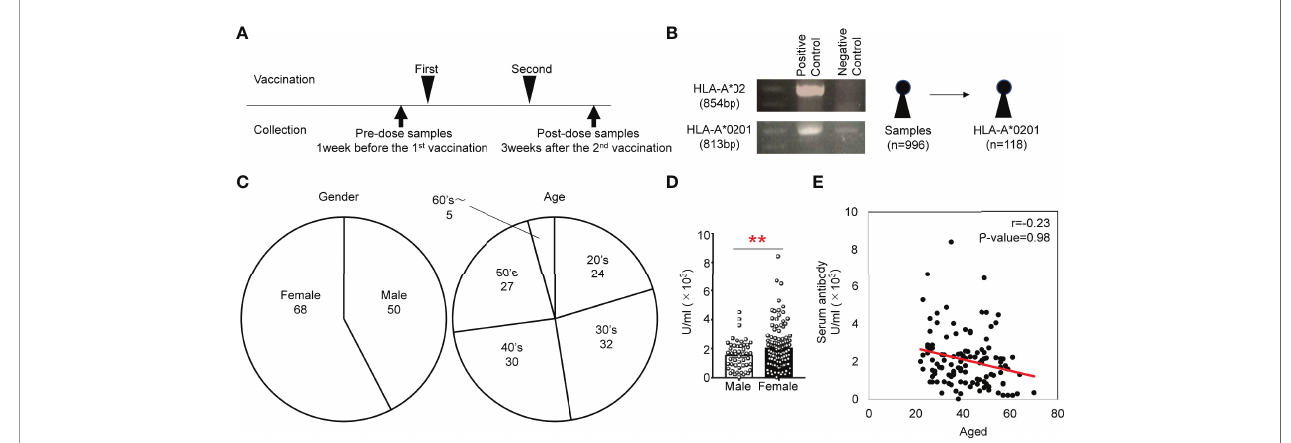
FIGURE 1 | (A) Study scheme for the collection of PBMCs from individuals administered the BNT162b2 vaccine. (B) Genotyping PCR analysis of genomic DNA from human white blood cells. Gel electrophoresis of the ampli fi ed HLA-A*02 fragment (854 bp) and HLA-*0201 fragment (813 bp). (C) Frequencies of sex and age of subjects that provided HLA-A*0201 + samples. (D) Antibody titers of males and females in HLA-A*0201 + samples of after vaccination. (E) Scatter plots of antibody titer and cell number of HLA-A*0201 + samples after vaccination. **p <